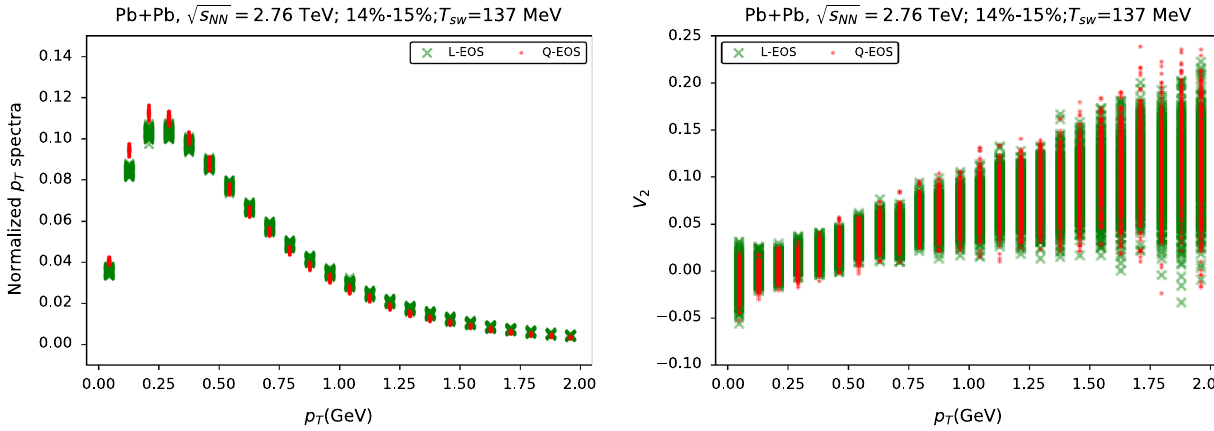
Fig. 9 Same as Fig. 8 but for 30-events-fine-averaged normalized p T spectra d N / N d y d p T (left panel) and elliptic flow v 2 as a function of p T (right